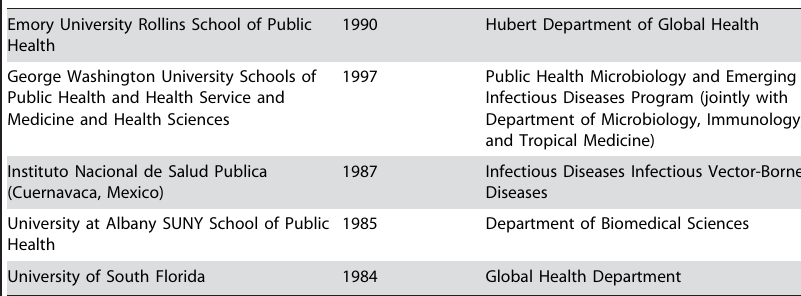
Table 2. US Accredited Public Health Schools Founded after 1970 with Academic Departments Devoted to Infectious and Tropical Diseases.